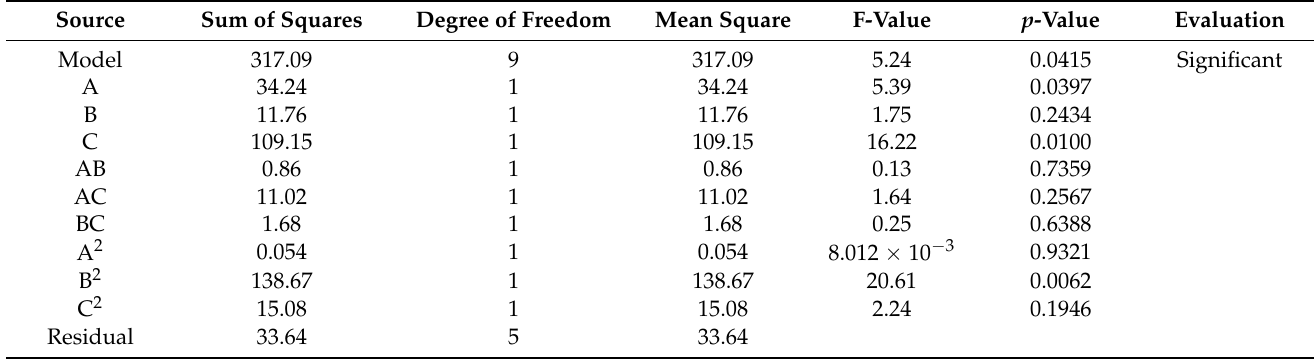
Table 5. Variance analysis of the quadratic polynomial model for EE 1 .